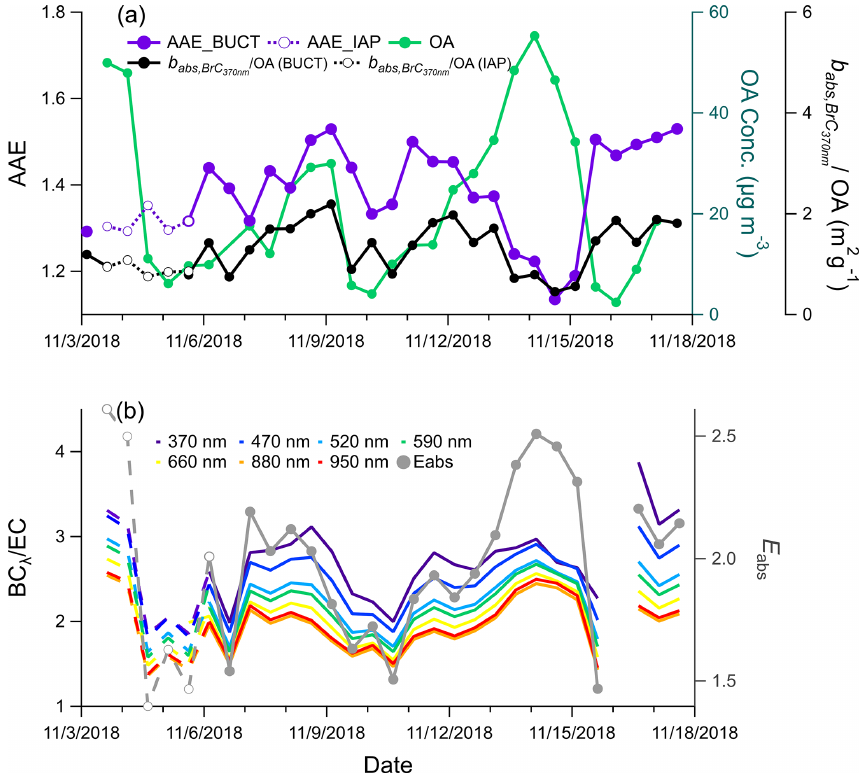
(normalized to OA), and OA measured by the ToF-ACSM during the Figure 5. (a) Time series of the AAE, normalized b abs , BrC 370nm sampling period; (b) ratio of BC to EC and E abs calculated with BC 880nm and EC. The solid lines represent the parameters measured at the BUCT site, and the dashed lines represent the parameters measured at the IAP site. The date is given in the format